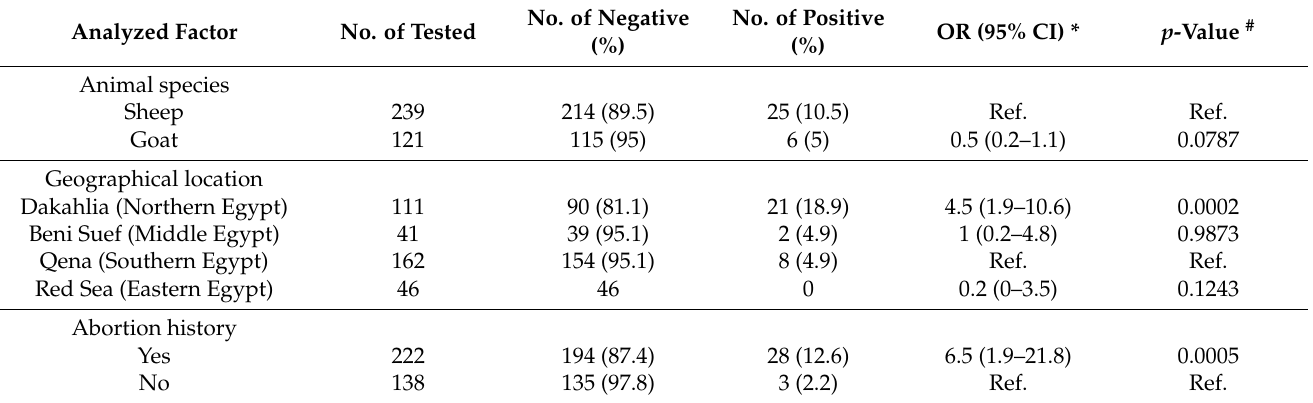
Table 6. Risk factors for Brucella spp. antibodies in sheep and goats in